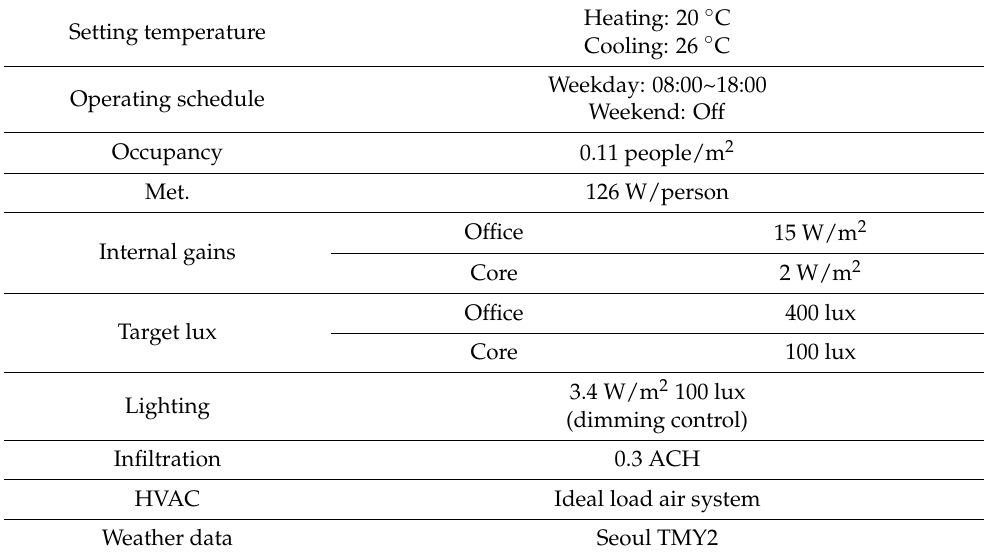
Table 3. Simulation setting